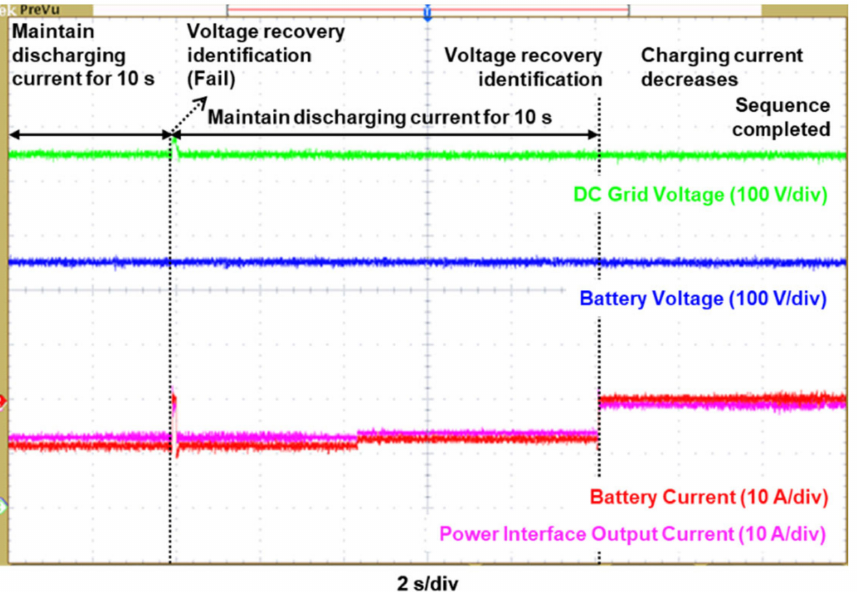
Figure 18. Completion sequence of proposed voltage regulation algorithm at overvoltage